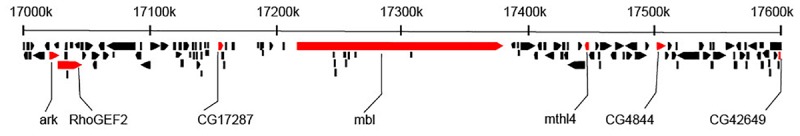
The 600 kb region of chromosome 2R of Drosophila melanogaster that was the primary focus of this study. This region was identified as a putative major effect locus for parasitoid resistance in an evolve and re-sequence study (Jalvingh et al., 2014). The figure shows the positions for the genes along the chromosome (based on Flybase version FB2019_01, dos Santos et al., 2014), highlighting the seven genes for which we successfully genotyped a SNP in individuals of Field lines and Selection and Control lines.